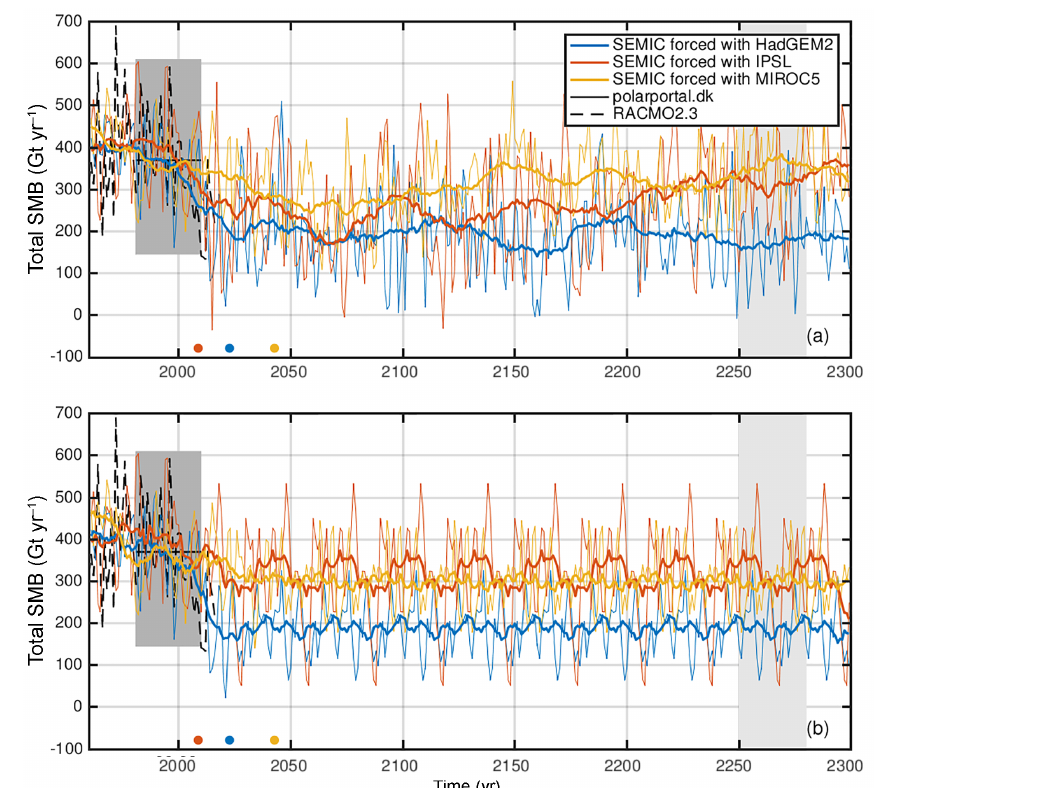
Figure 4. Time series of the annual mean integrated SMB clim (Gtyr − 1 ) according to Eq. (4) for all three SEMIC-GCMs under RCP2.6 forcing (a) and RCP2.6 forcing without overshoot (b) . The solid line is a 30-year and 15-year moving mean in (a) and (b) , respectively. The darker gray shading and black line represent the range and mean of SMB between 1981 and 2010 from Polar Portal (http://polarportal.dk/ forsiden/, last access: 8 October 2018). The dashed line shows the SMB time series of RACMO2.3 (Noël et al., 2018) from 1958–2016. The coloured dots represent the onset years of overshooting 1.5 ◦ C in the global mean near-surface air temperature in a 30-year moving window relative to pre-industrial levels. The light gray shaded time period indicates the repeated SMB forcing taken from the RCP2.6 scenario for the scenario without